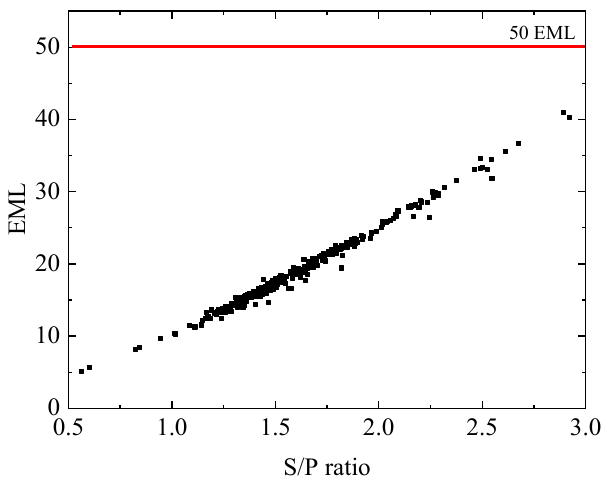
Figure 6. EML as a function of the S / P ratio at 30 lx.